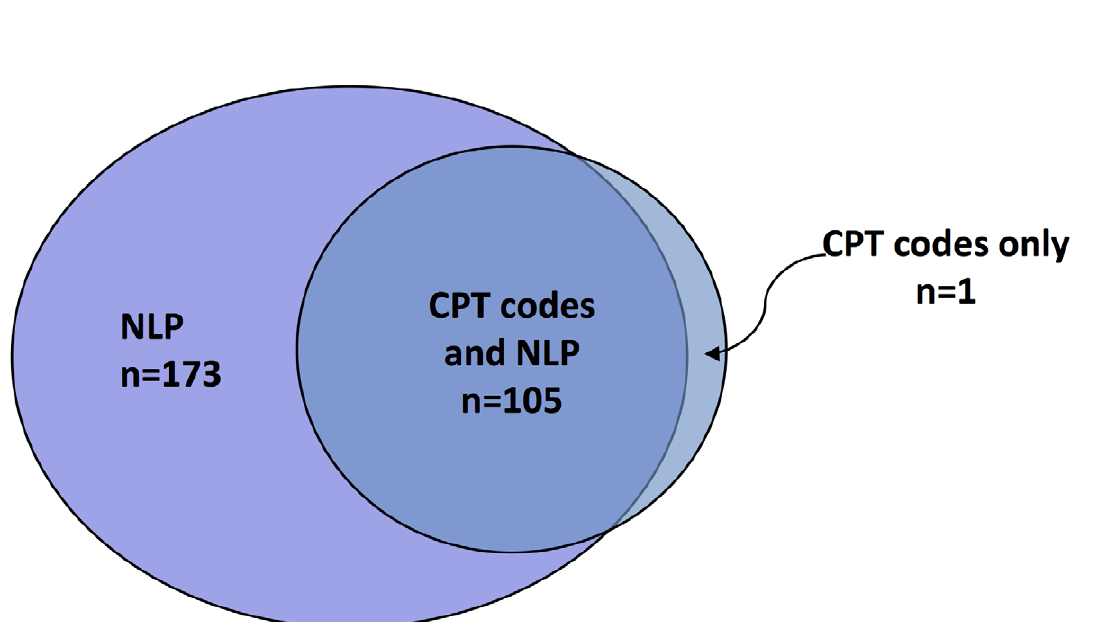
Figure 1. Comparison of natural language processing (NLP) and CPT codes to detect completed colonoscopies in 200 patients. In this study, more completed colonoscopies were found via NLP than with billing codes alone, and only one colonoscopy was found with billing codes that was not found with NLP. NLP examples were reviewed for accuracy. doi:10.1371/journal.pcbi.1002823.g001 PLOS Computational Biology |